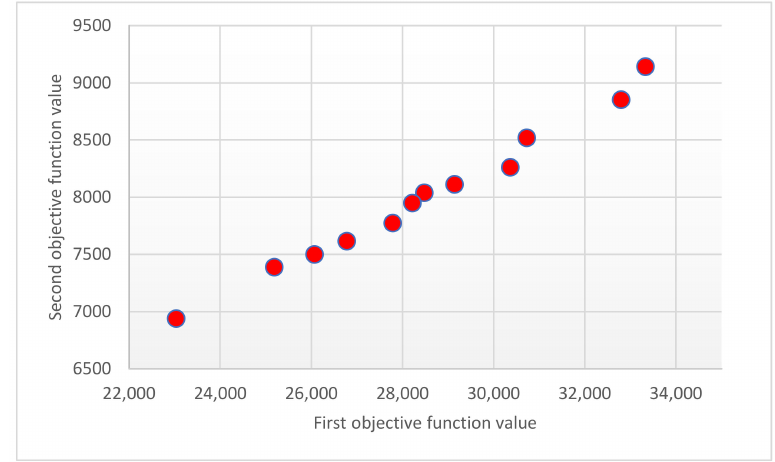
Figure 3. Pareto front of first objective function and second objective function.